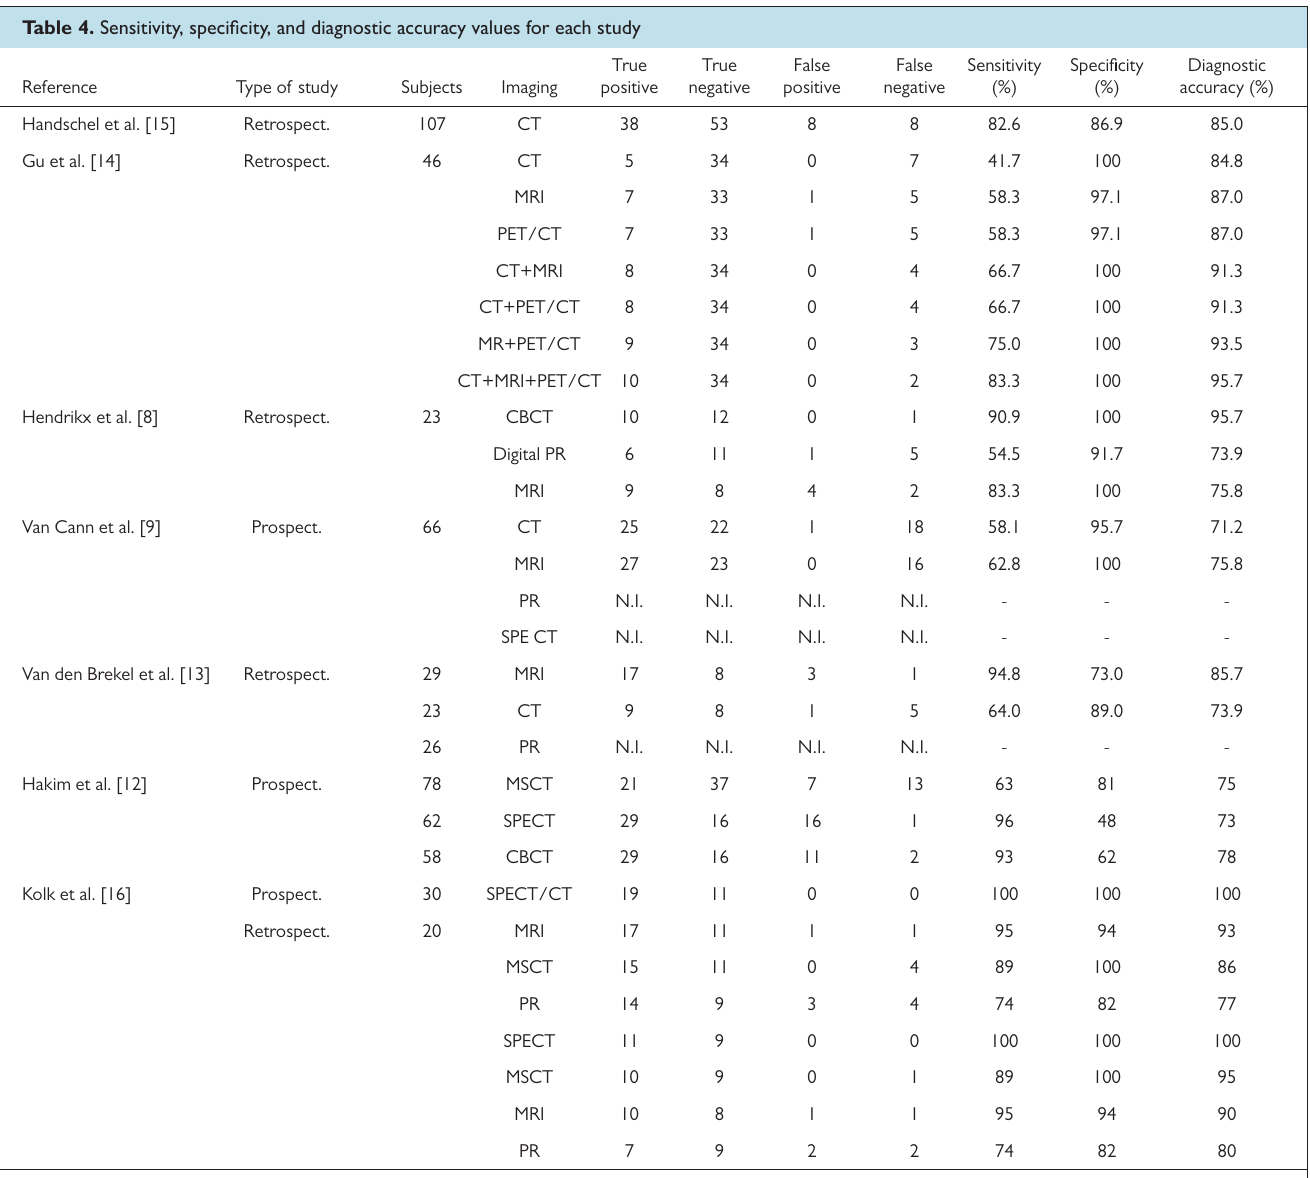
True Specificity